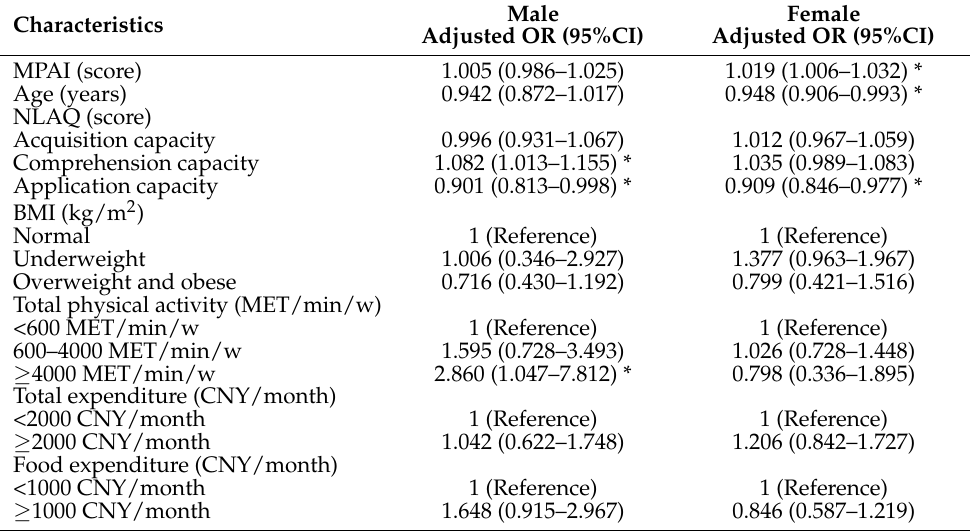
Table 4. Multivariate logistic model to explore MPAI and other potential factors that may influence sugar/chocolate intake stratified by